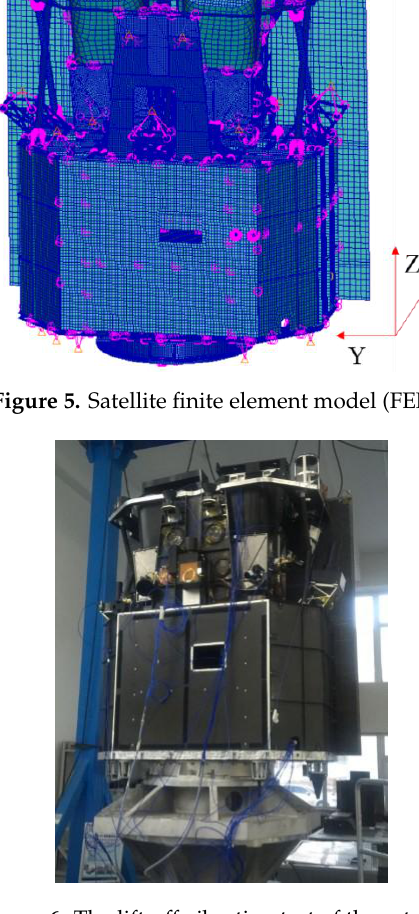
Figure 6. The lift-off vibration test of the satellite.